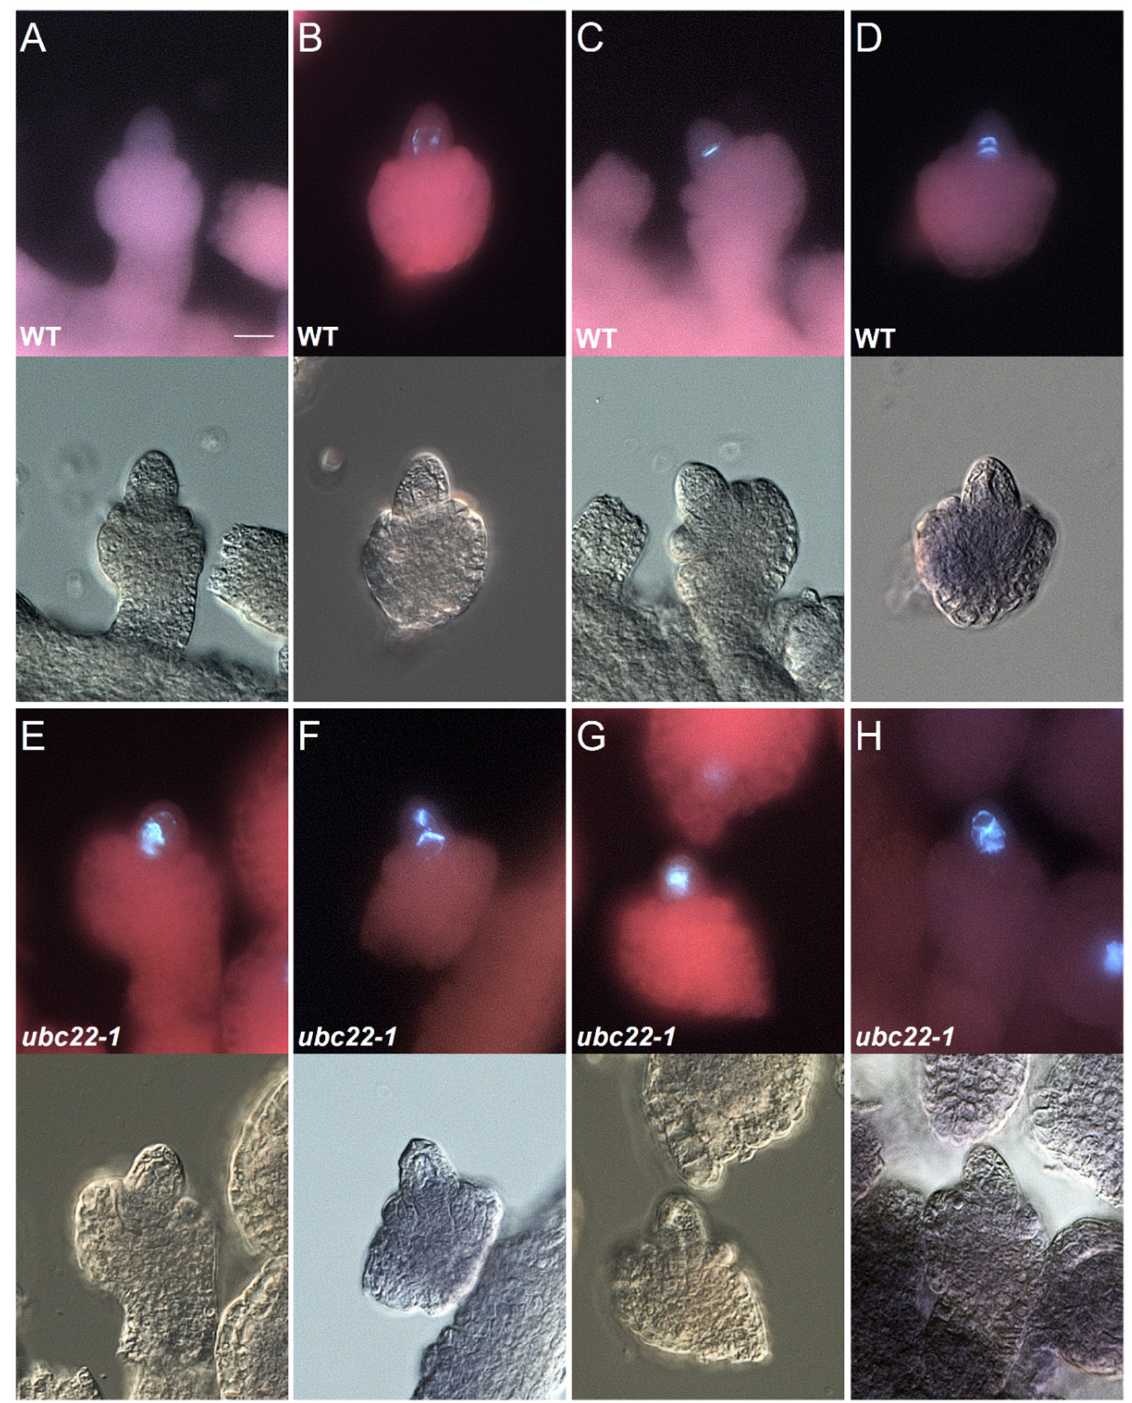
Figure 1. Callose formation in the early stages of megasporogenesis in WT and ubc22-1 mutant ovules. For each ovule, the callose fluorescent image is shown on the top, and the bright-field image is shown on the bottom. WT ( A – D ) and ubc22-1 mutant ( E – H ). Scale bar in (A): 10 μ m. ( A ) No callose staining in a WT ovule before meiosis. ( B ) Deposition of callose along the cell wall of a WT MMC. ( C ) A clear callose band indicating the place of newly formed cell plate from the first meiotic division by a WT MMC. ( D ) Two clear callose bands as a result of the first meiotic division and the second division by the nucleus close to the chalazal end. ( E ) A callose band with diffused callose disposition in a ubc22-1 MMC. ( F ) A callose band as well as callose deposition in other locations of a ubc22-1 MMC. ( G ) Strong callose staining in the center of a ubc22-1 MMC, but the callose band is not clear. ( H ) Disorganized callose deposition without a clear band in a ubc22-1 MMC.